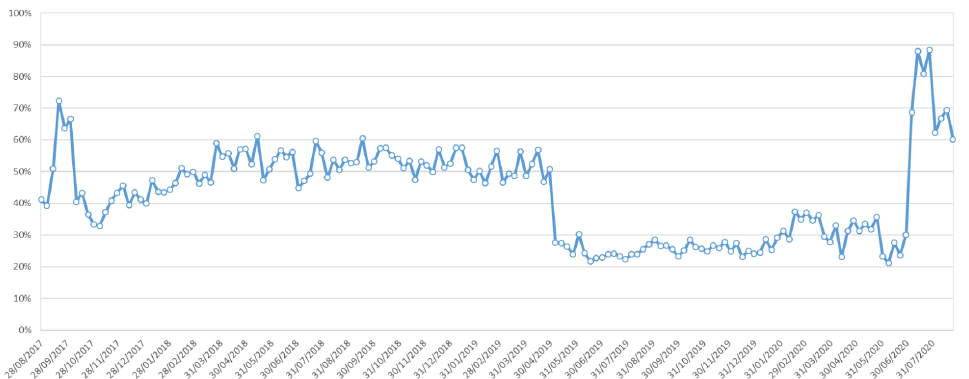
Figure 4. Weekly ratio between the number of contributors to the NoiseCapture database and NoiseCapture installs.